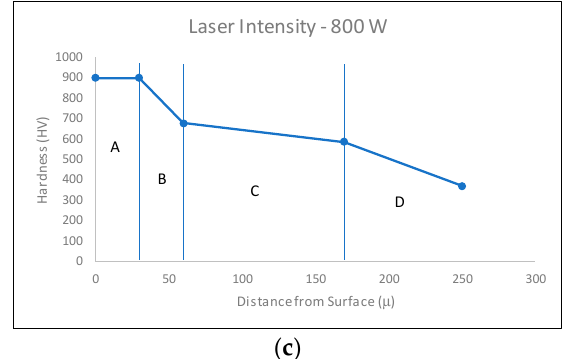
Figure 5. Hardness profile of Ti-6Al-4V alloy after nitriding process: (A) Melted region; (B) Heat affected zone; (C) Grain growth region; (D) Base material. ( a ) Laser Intensity—700 W; ( b ) Laser Intensity—750 W; ( c ) Laser Intensity—800 W.